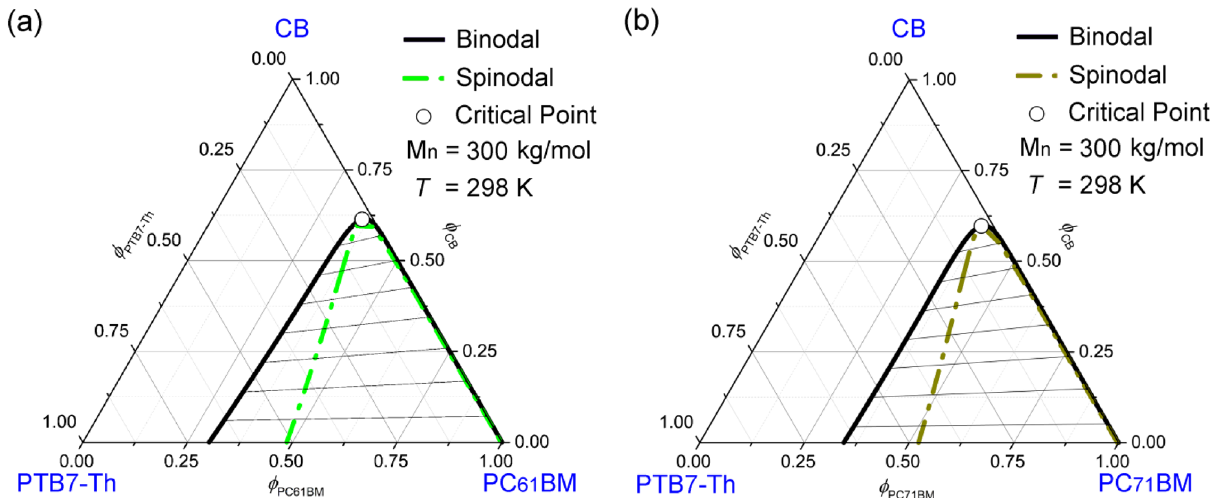
Figure 4. Phase diagrams for the ternary CB/PTB7-Th/Fullerene system as a function of electron acceptors: PTB7-Th’s M n = 300 kg/mol and T = 298 K. ( a ) CB/PTB7-Th/PC 61 BM: χ 12 = 0.35 , χ 13 = 0.90 , χ 23 = 1.03 , s = 0.000389, and r = 0.167068. ( b ) CB/PTB7-Th/PC 71 BM: χ 12 = 0.35 , χ 13 = 0.84 , χ 23 = 0.96 , s = 0.000389, and r = 0.147613.